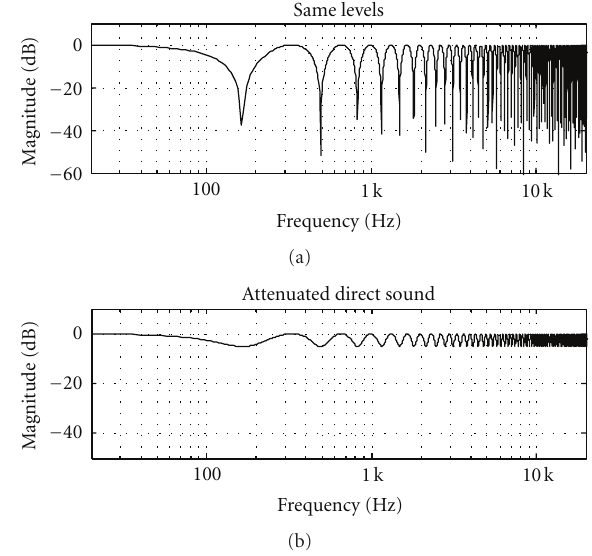
Figure 20: FIR comb filter, delay 3ms. (a) illustrates the comb filtering e ff ect, when the signals have the same energy, whereas (b) illustrates the e ff ect when the passive attenuation of the headset (at the frequency of the first notch − 13 dB at 170Hz) is taken into